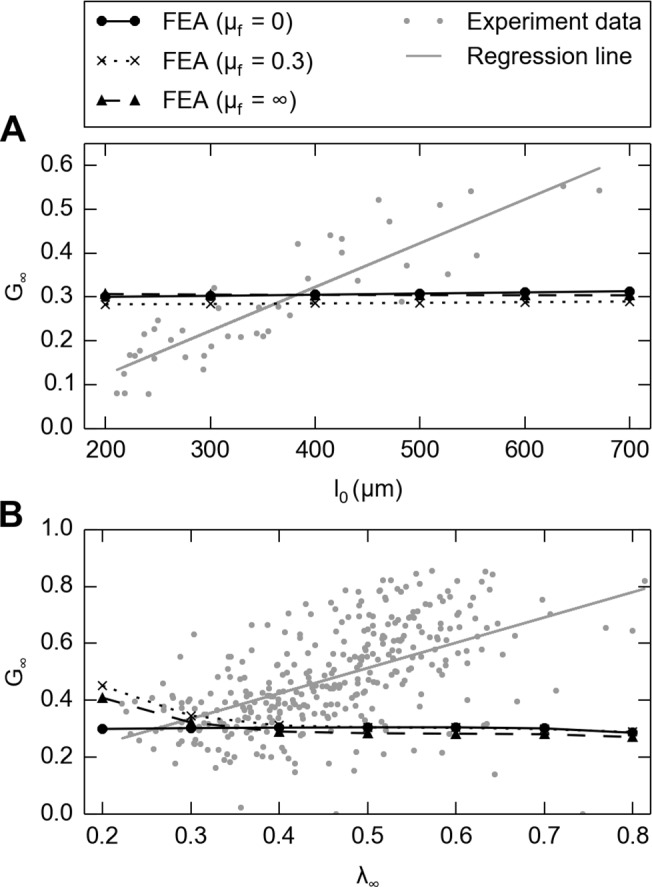
FE analysis shows minimal frictional edge effects on the calculated residual stress ratio, A: when skin thickness changes, plotted on top of Fig. 6A; and B: when strain level changes, plotted on top of Fig. 6B.